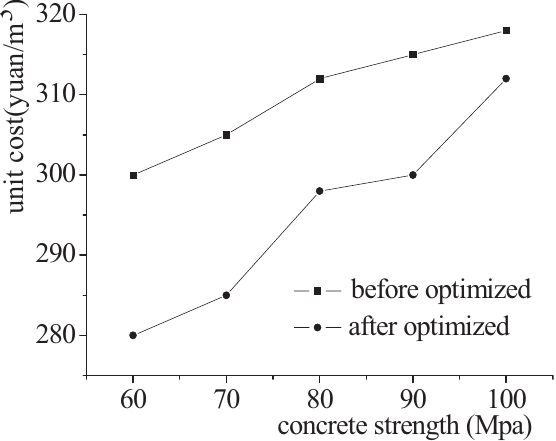
Fig. 3. Comparative analysis of concrete unit cost.